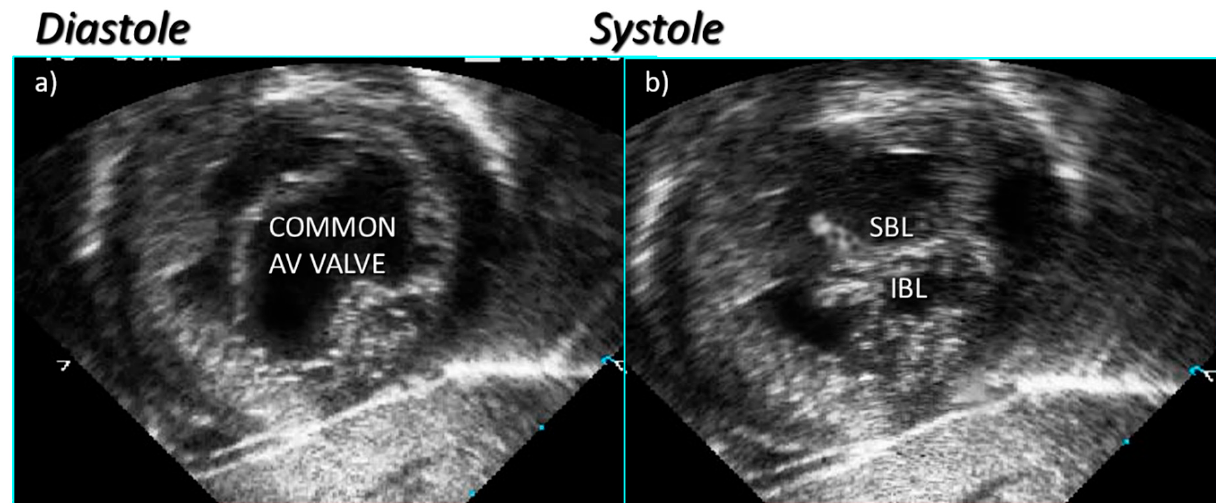
Figure 5. Subcostal left oblique short axis echocardiographic section of AV junction at level of AV valve leaflets showing ( a ) common atrioventricular valve during atrial systole and ( b ) the zone of apposition of the superior and inferior bridging leaflets.